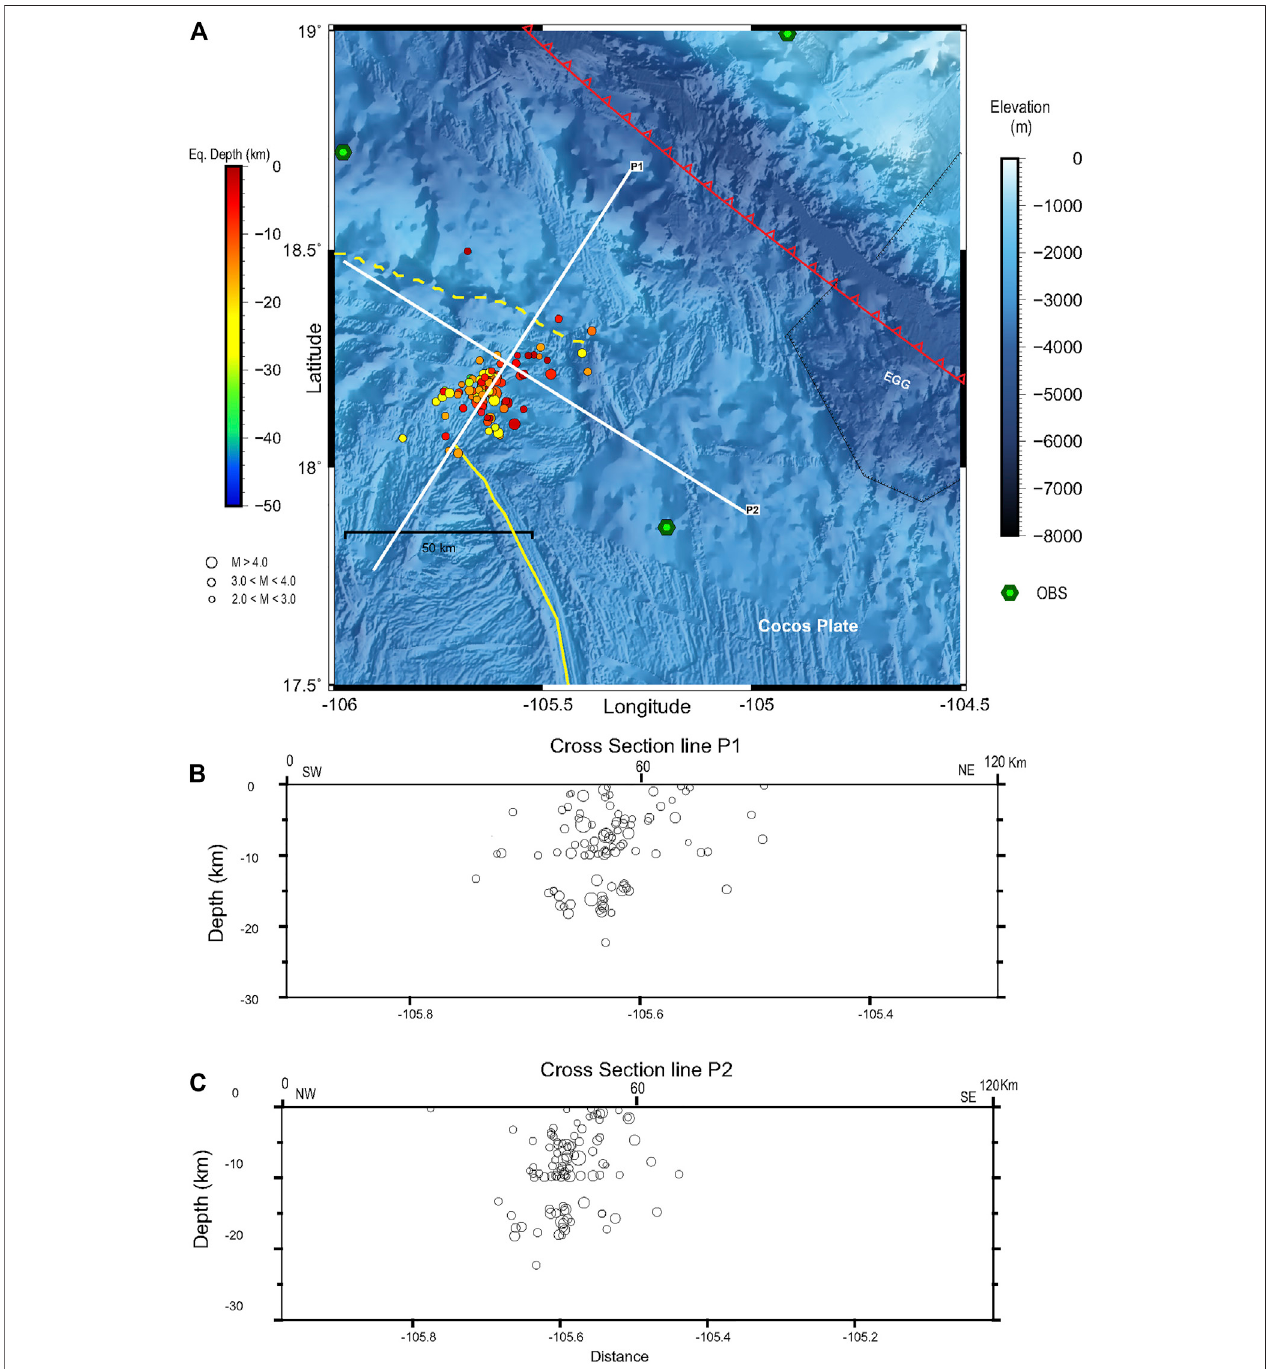
FIGURE 5 | (A) Epicentral map showing the May 7 – 10, 2016 swarm (86 earthquakes) located with Hypo-71 using OBS data and P-wave velocity model SVR01. The white lines are the projection of seismicity throughout P1 and P2 transects with a width of 20 km; (B) Cross-section along P1 line; (C) Cross-section along P2 line. Abbreviations as for Figure 1